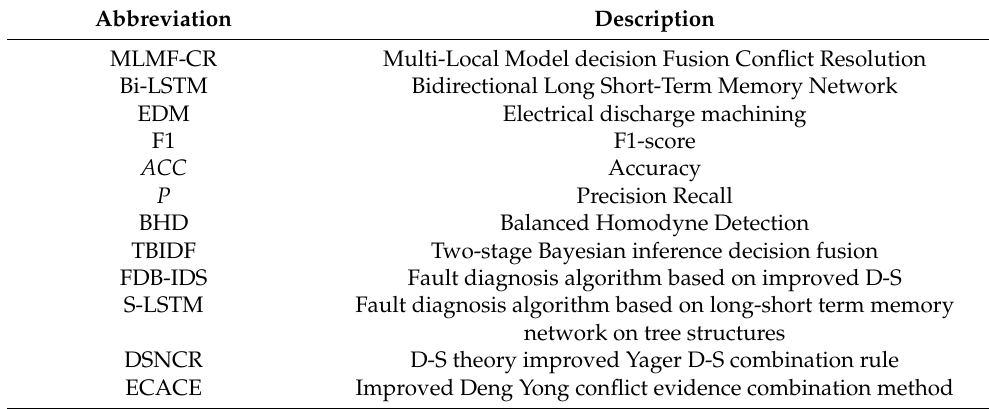
Table 1. The abbreviations used in this